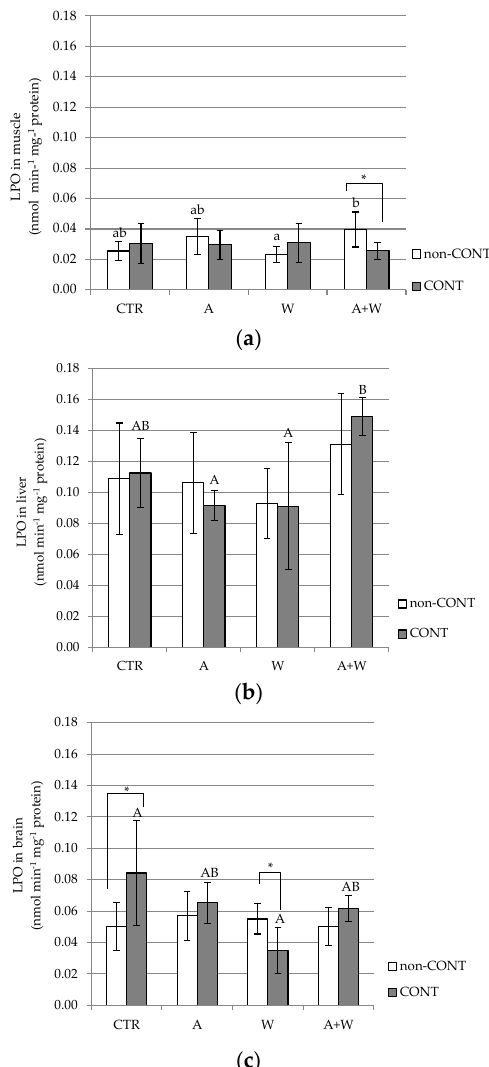
Figure 4. Lipid peroxidation in malonaldehyde (MDA) concentration (nmol ∙ mg − 1 protein, mean ± SD) in S. senegalensis muscle ( a ), liver ( b ), and brain ( c ) after 28 days of Hg exposure. White bars represent non-contaminated treatments (non-CONT) and gray bars represent Hg-contaminated treatments (CONT). CTR—seawater temperature set at 19 °C and pH set at 8.0 units; A—seawater temperature set at 19 °C and pH set at 7.6 units; W—seawater temperature set at 23 °C and pH set at 8.0 units; A + W—seawater temperature set at 23 °C and pH set at 7.6 units. Different small letters denote significant di ff erences between non-CONT treatments (ANOVA, p < 0.05). Di ff erent capital letters denote significant di ff erences between CONT treatments (ANOVA, p < 0.05). Asterisks (*) represent di ff erences between non-CONT and CONT for the same conditions (Student’s t -test: * p < 0.05). Brain AchE activity in non-CONT and CONT fish is shown in Figure